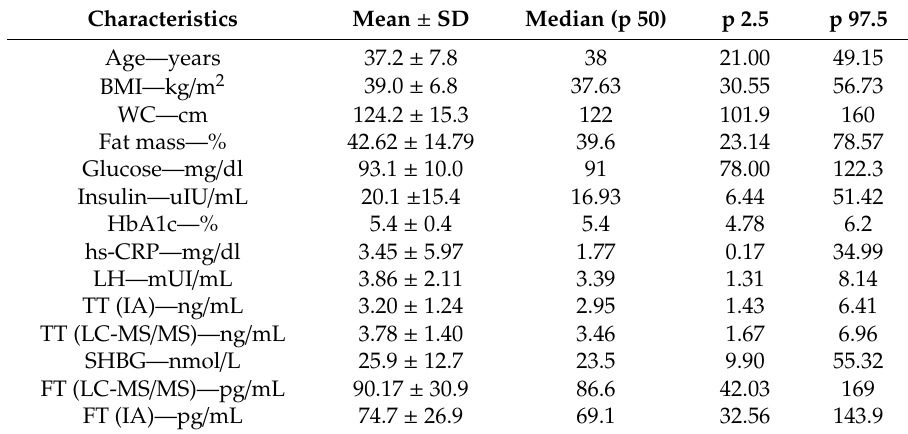
Table 1. Clinical characteristics of the study population ( n = 273).